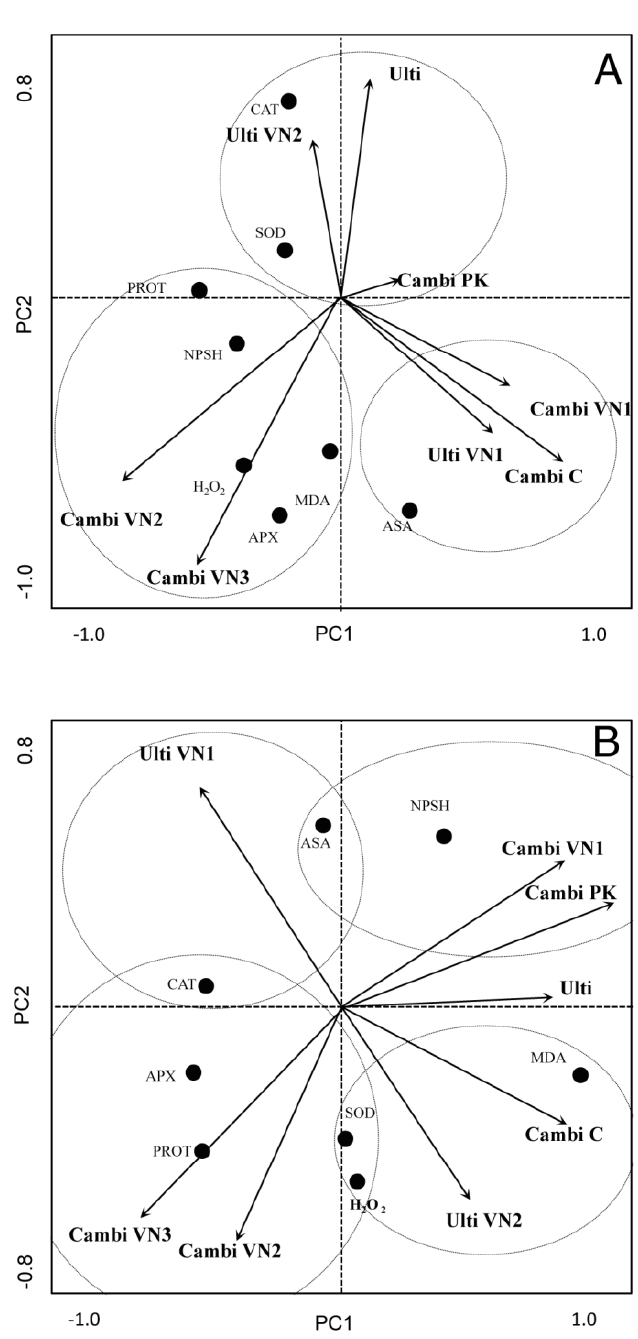
Fig. 9: Biplot graphic of scores and weights (loadings) for the first two principal components (PC1 and PC2) for biochemical parameters and tested soils 15 days before harvesting for SMINIA793101-3 (A) and SMIF212-3 (B) genotypes. MDA (lipid peroxidation); H2O2 (hydrogen peroxide concentration); SOD (Superoxide dismutase activity); CAT (catalase activity); APX (ascorbato peroxidase acti- vity); PROT (protein concentration); AsA (ascorbic acid concen- tration); NPSH (non-protein thiol groups concentration). stage, H 2 O 2 concentration was not clustered with MDA, but near to the end of plant cycle these parameters were correlated. This pattern may be due to H 2 O 2 function of signaling ( t aMáS et al., 2004) and the insufficient action of antioxidant system to prevent biological damage, which resulted in high MDA concentrations at the end of the plant